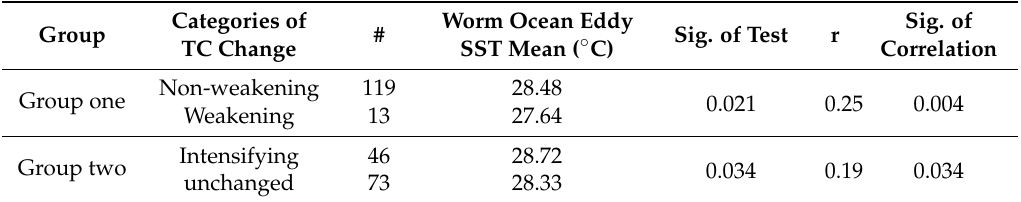
T -test analysis of the differences in SST of the warm ocean eddies that encounter non-weakening and weakening TCs and of the warm ocean eddies that encounter intensifying and unchanged TCs. Correlation coefficients (r) between SST and change of TC intensity in these two groups are also